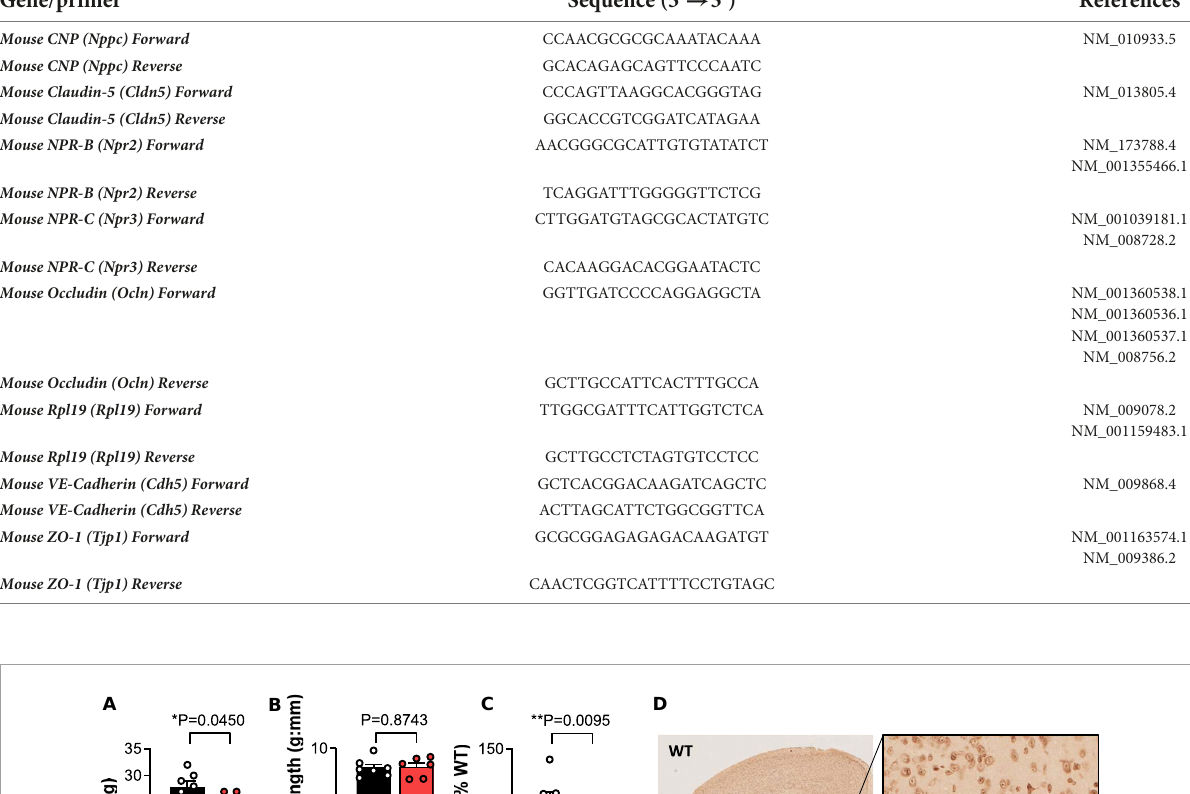
TABLE 2 Mouse primer sequences with corresponding database reference. Gene/primer Sequence (5 (cid:48) → 3 (cid:48) )